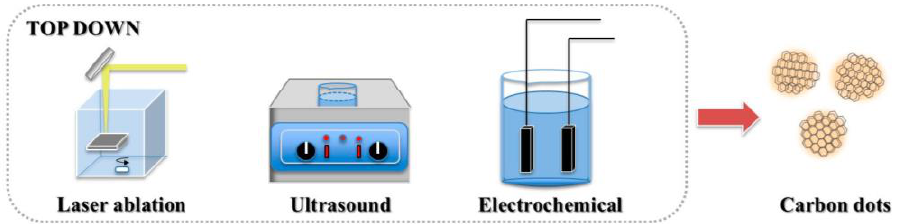
Figure 3. Top-down methods for the synthesis of CDs [55].